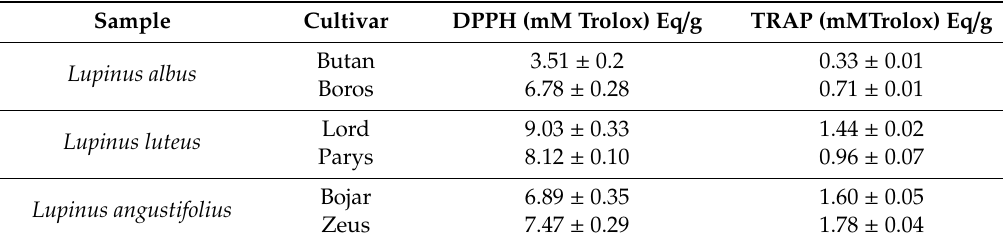
Table 7. Antioxidant capacity of lupine seed